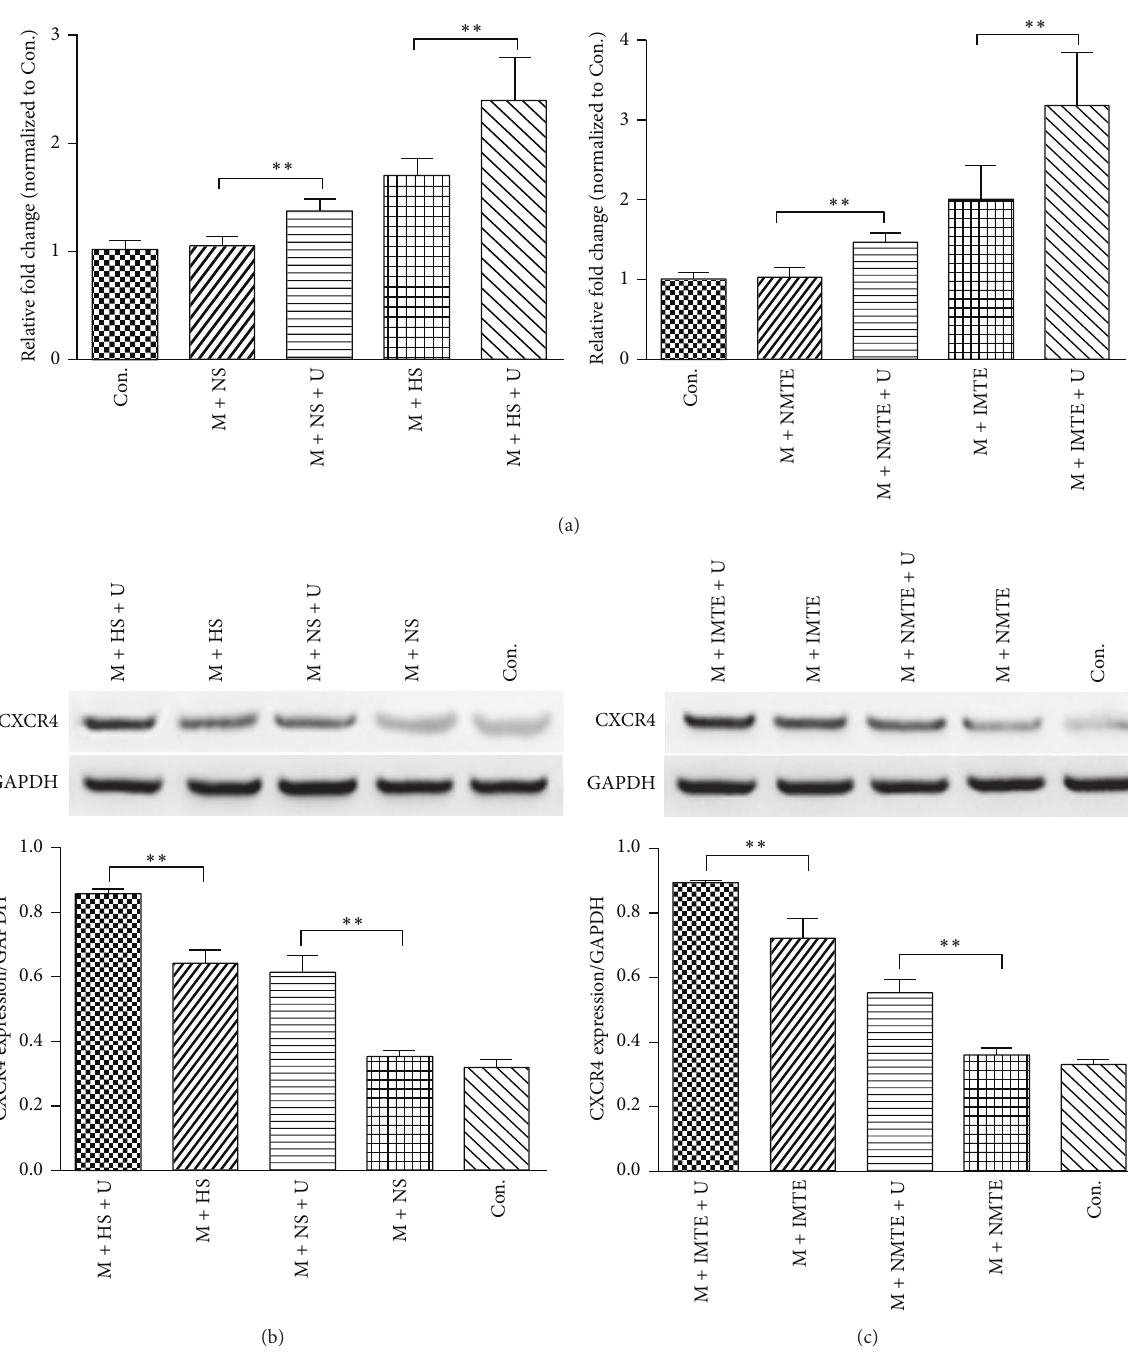
Our results in this work showed that higher